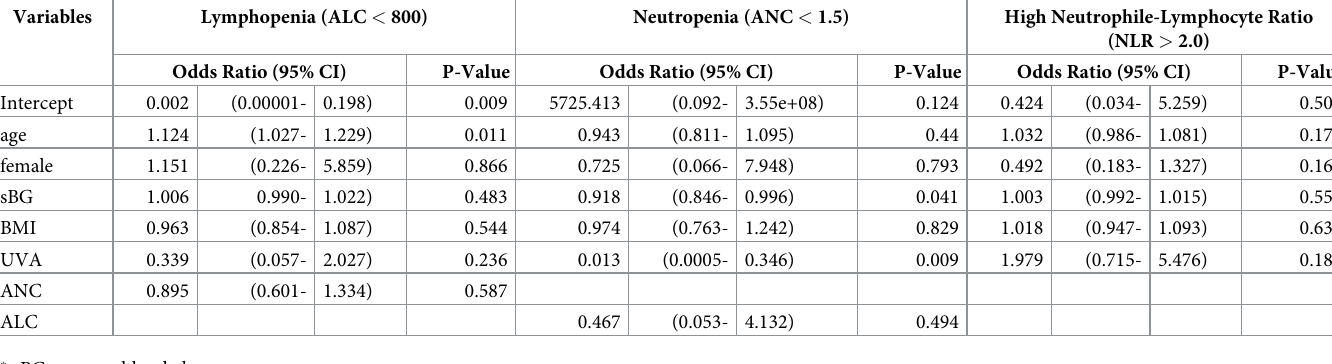
Table 3. Mixed model regression results for ALC < 800, ANC < 1.5, and NLR > 2.0 in the combined cohort (N = 339) � . Variables Lymphopenia (ALC < 800)